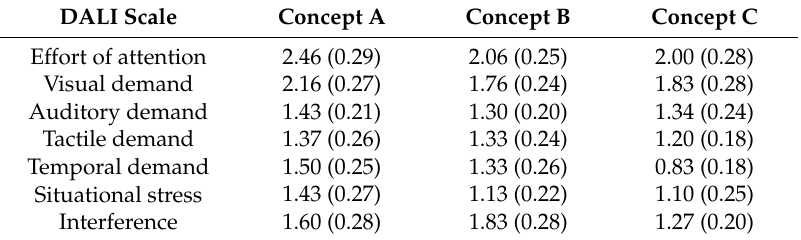
Table 5. Experienced workload mean and (SD) for concepts A, B, and C.